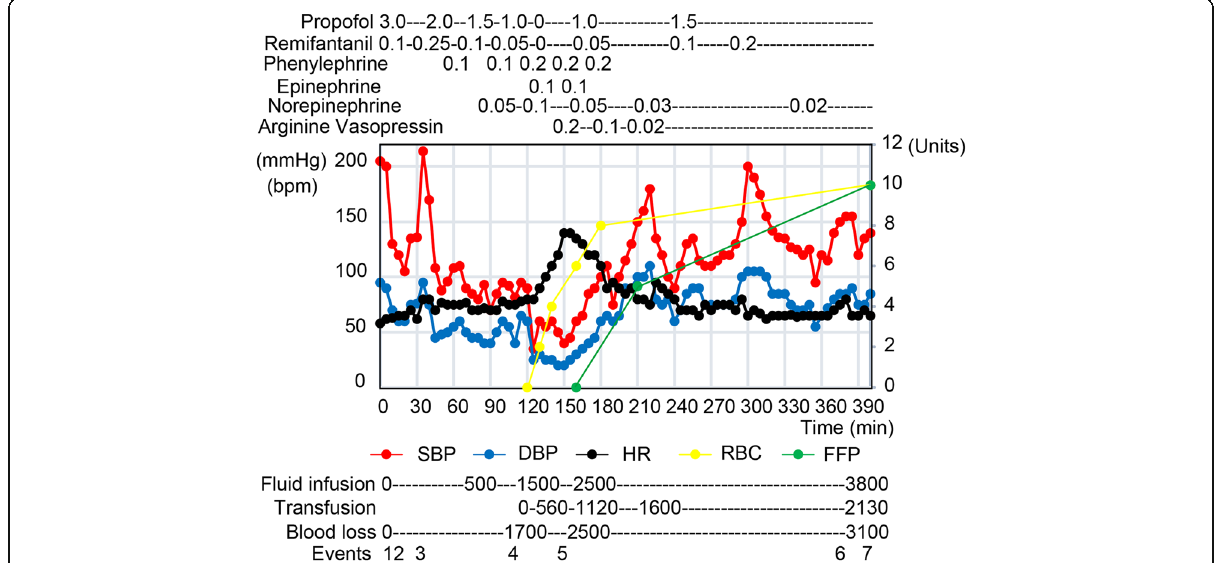
Fig. 1 Anesthetic records for the patient. Propofol: target controlled infusion ( μ g/ml). Remifentanil: continuous infusion ( μ g/kg/min). Phenylephrine: bolus injection (mg), Epinephrine: bolus injection (mg). Norepinephrine: continuous injection ( μ g/kg/min), Arginine vasopressin: continuous injection (U/kg/h). Fluid infusion, transfusion, and blood loss are represented as milliliter. 1, start of anesthesia. 2, tracheal intubation. 3, start of surgery. 4, injury to and 5, repair of the inferior vena cava. 6, end of surgery. 7, end of